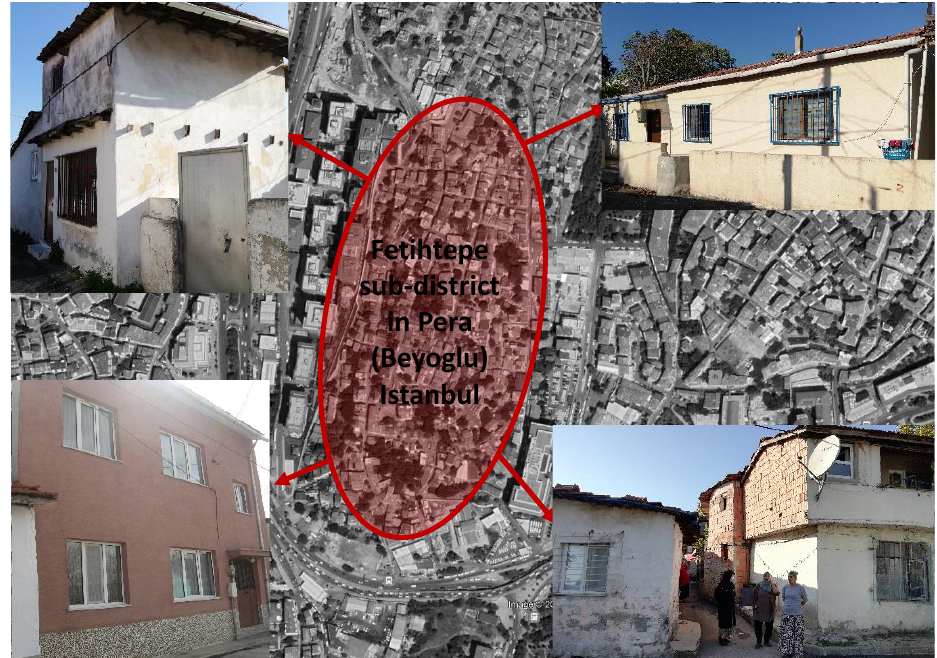
Figure 16. Fetihtepe sub-district in Pera (Beyoglu), which is a good example of an old urban center in a highly populated earthquake-prone city of Istanbul. The district is composed of numerous non-engineered URM buildings, for which the seismic risk should be assessed before the expected major earthquake hits Istanbul.